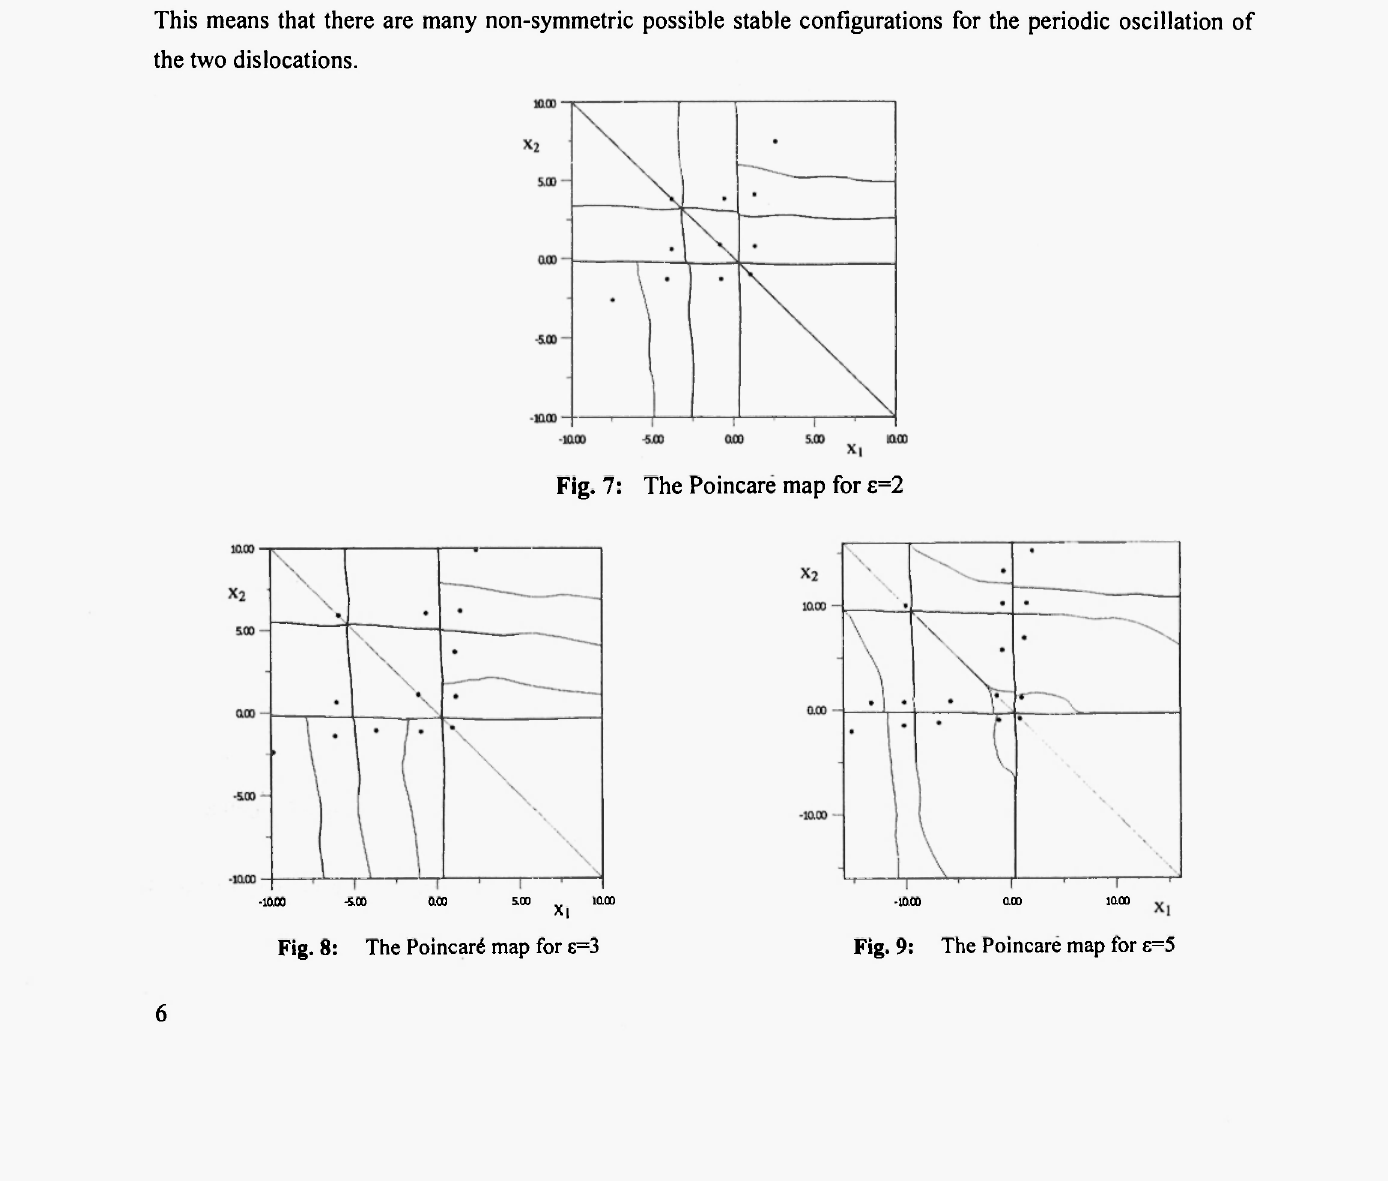
Fig. 7: The Poincare map for ε=2